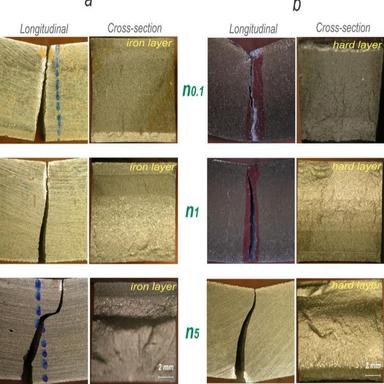
Optical images of the bending-induced fractured FGMs loaded from a) iron surface and b) hard surface.